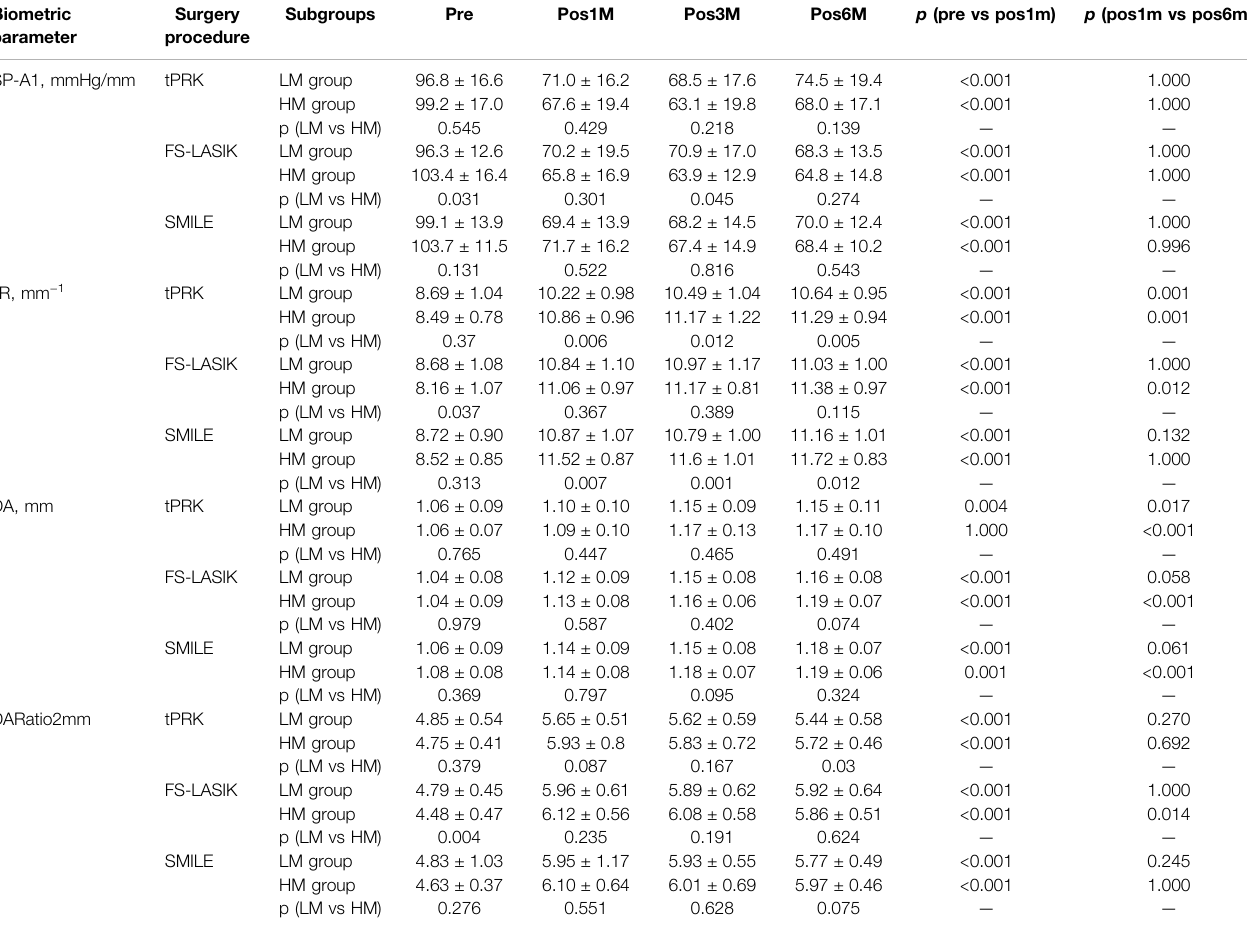
TABLE 2 | Biomechanical metrics provided by Corvis ST before and after three forms of corneal refractive surgery. Biometric Surgery parameter procedure